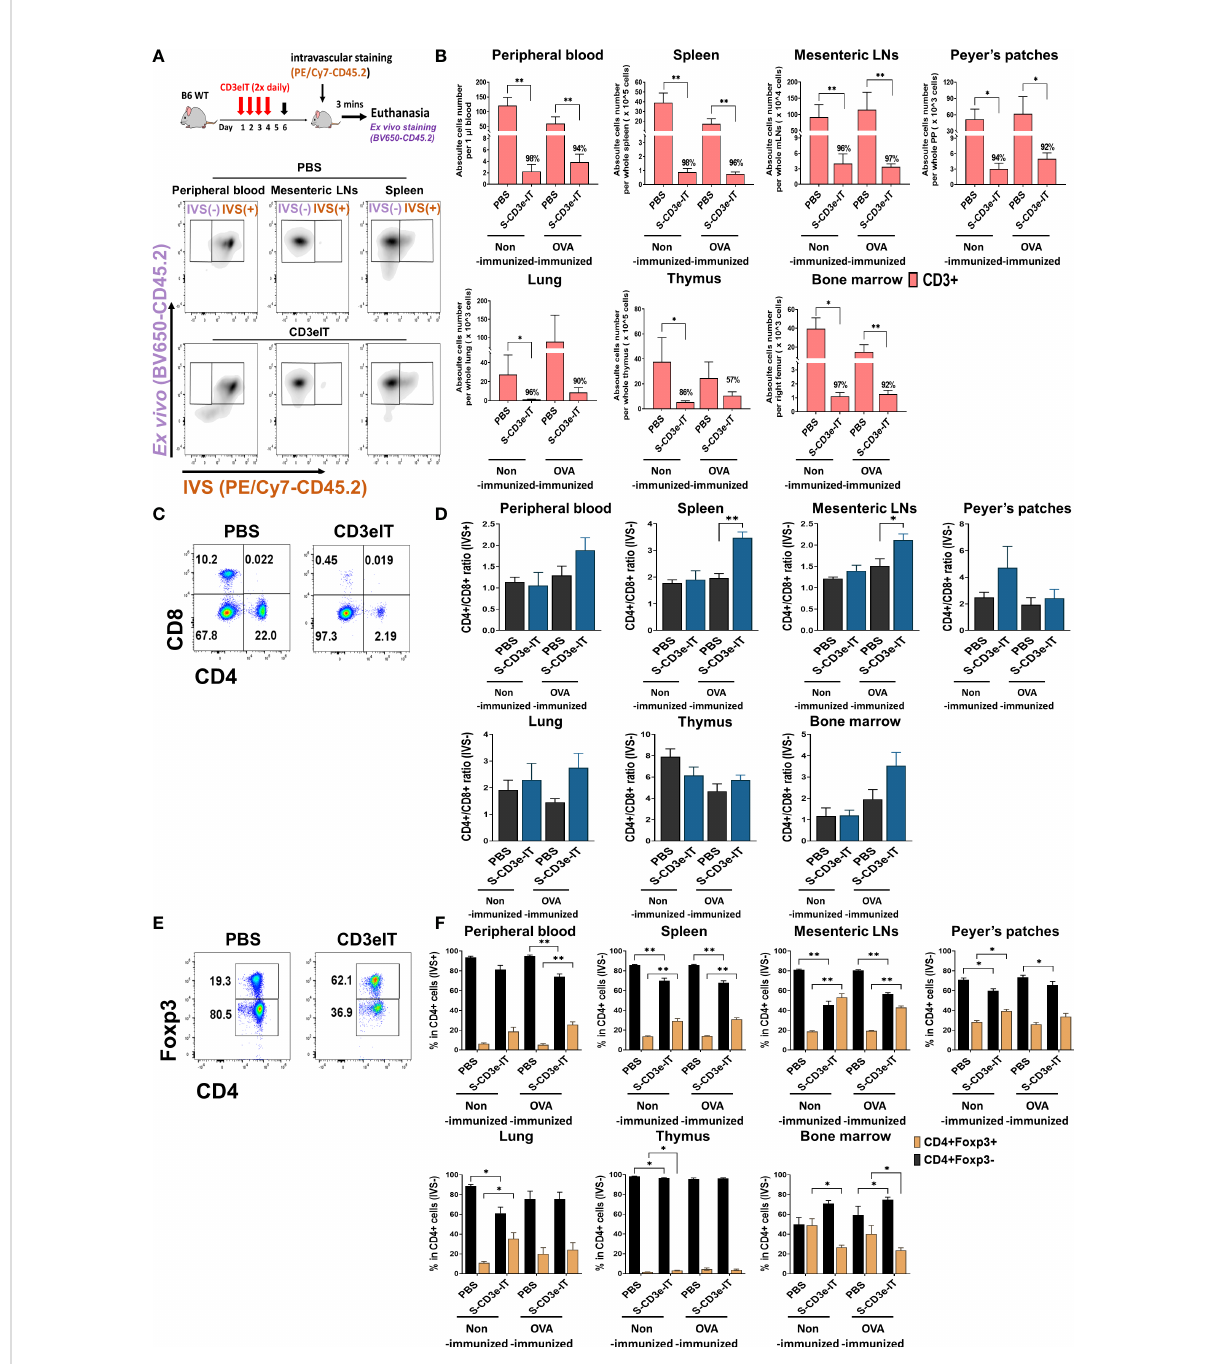
FIGURE 1 CD4+Foxp3+ Tregs cells enrichment following S-CD3e-IT treatment. (A) The diagram shows an S-CD3e-IT treatment (Upper panel) and intravascular staining strategy (Lower panel) to analyze the effect of S-CD3e-IT ef fi cacy on circulating and different Tissue-resident T cells. The fl ow cytometry gating strategy shows circulating (IVS+) and tissue-resident cells (IVS-) separation in peripheral blood, mesenteric LNs, and spleen. (B) The absolute number of CD3+ cells (y-axis) is shown for the peripheral blood (IVS+) and tissue-resident (IVS-) portions of the spleen, mesenteric LNs, Peyer ’ s patches, lung, thymus, and bone marrow. Absolute cell numbers were calculated based on CountBright Absolute counting beads and total cell counts per organ. (C, D) Flow cytometry for CD4+ and CD8+ T cells (C) and the ratios of CD4+ to CD8+ for all tested organs (D) are shown. (E, F) Flow cytometry for CD4+Foxp3- and CD4+Foxp3+ T cells (E) and % of these cells in CD4+ cells (F) are shown for all tested organs. Nonimmunized mice treated with PBS ( n = 4~5, depending on organs), or S-CD3e-IT ( n = 4~6), OVA-immunized mice treated with PBS ( n = 3~4), or S-CD3e-IT ( n = 7~8), were compared. (* p < 0.05 and ** p <